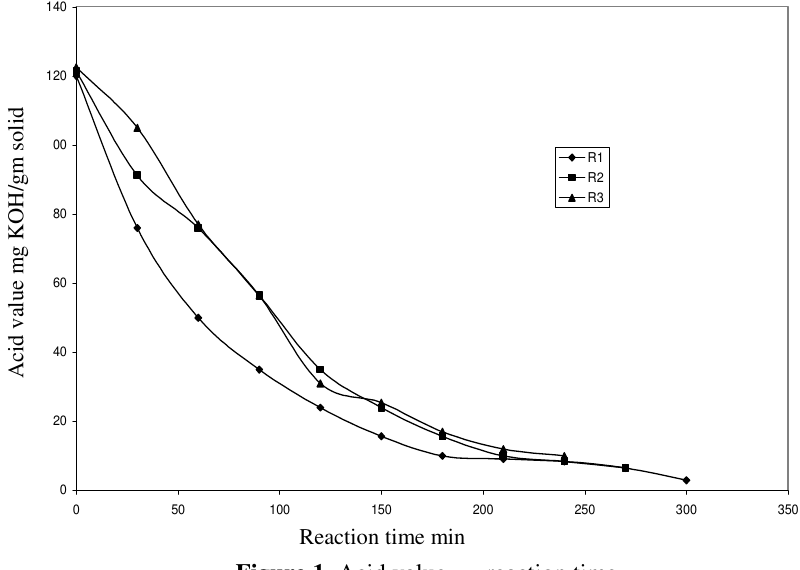
Figure 1. Acid value vs . reaction